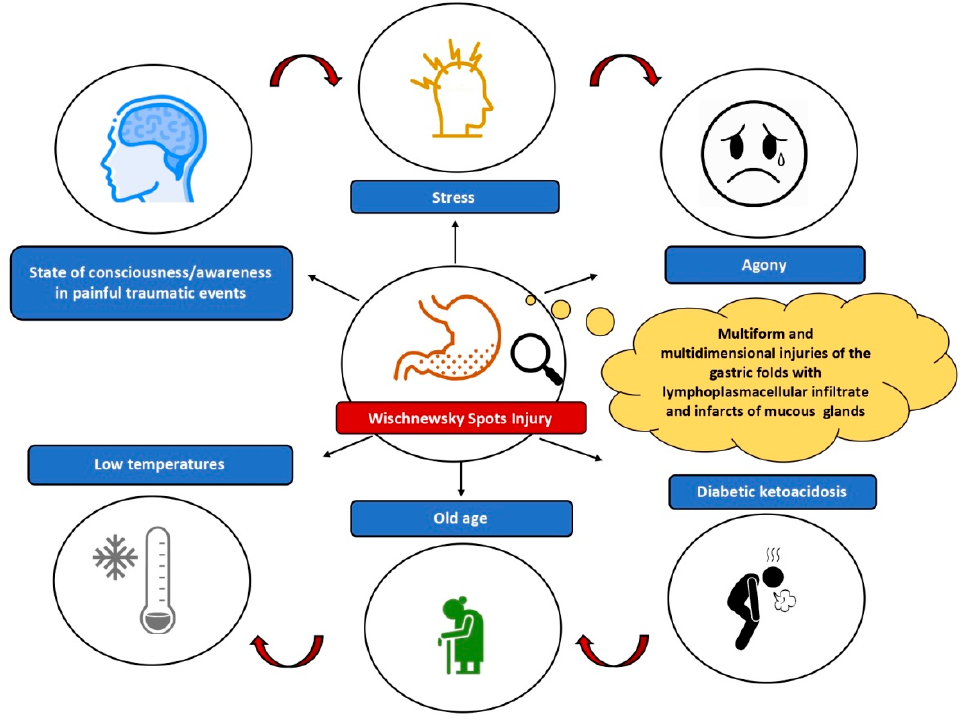
Figure 4. Multifactorial pathophysiology of WS.